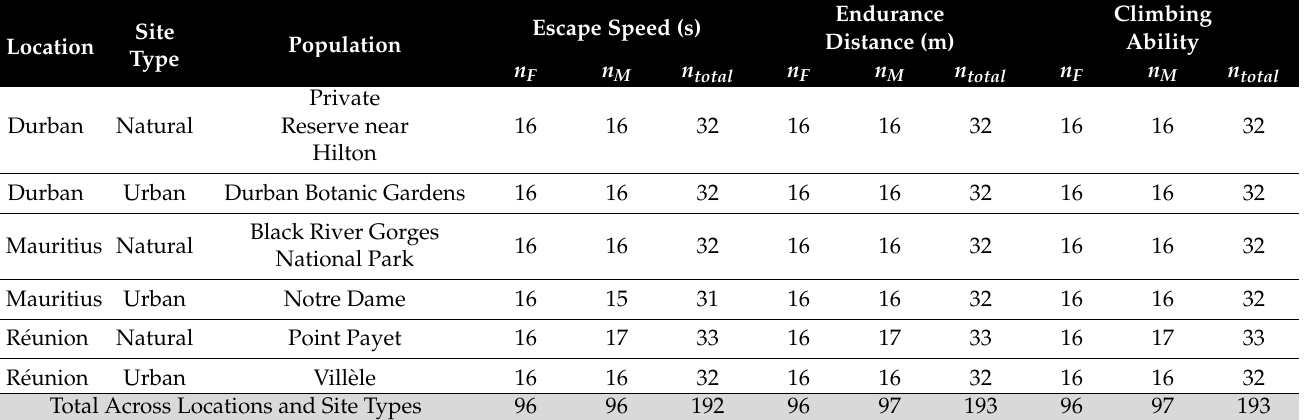
Table 2. Sample sizes of guttural toads ( Sclerophrys gutturalis ) for which performance and climbing ability were recorded, separated by study location, site type, sex (F/M), and population. Durban is within the native range of this species and hosts the source population of the two studied locations within its invasive range (Mauritius and R é